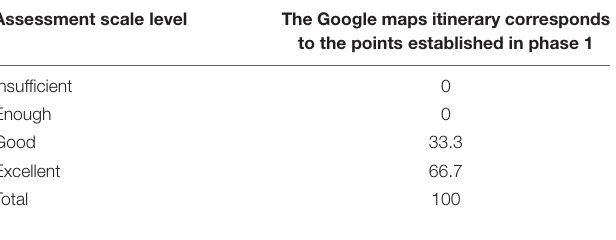
TABLE 4 | Results of the level of performance according to indicators chosen from the assessment scale.